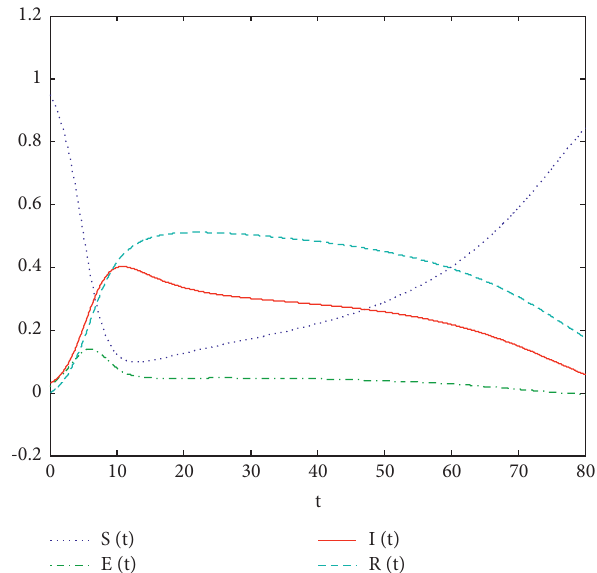
Figure 9: The population density curve of netizens in the four categories with parameter α � 1 . 5 − 0 . 02 t .